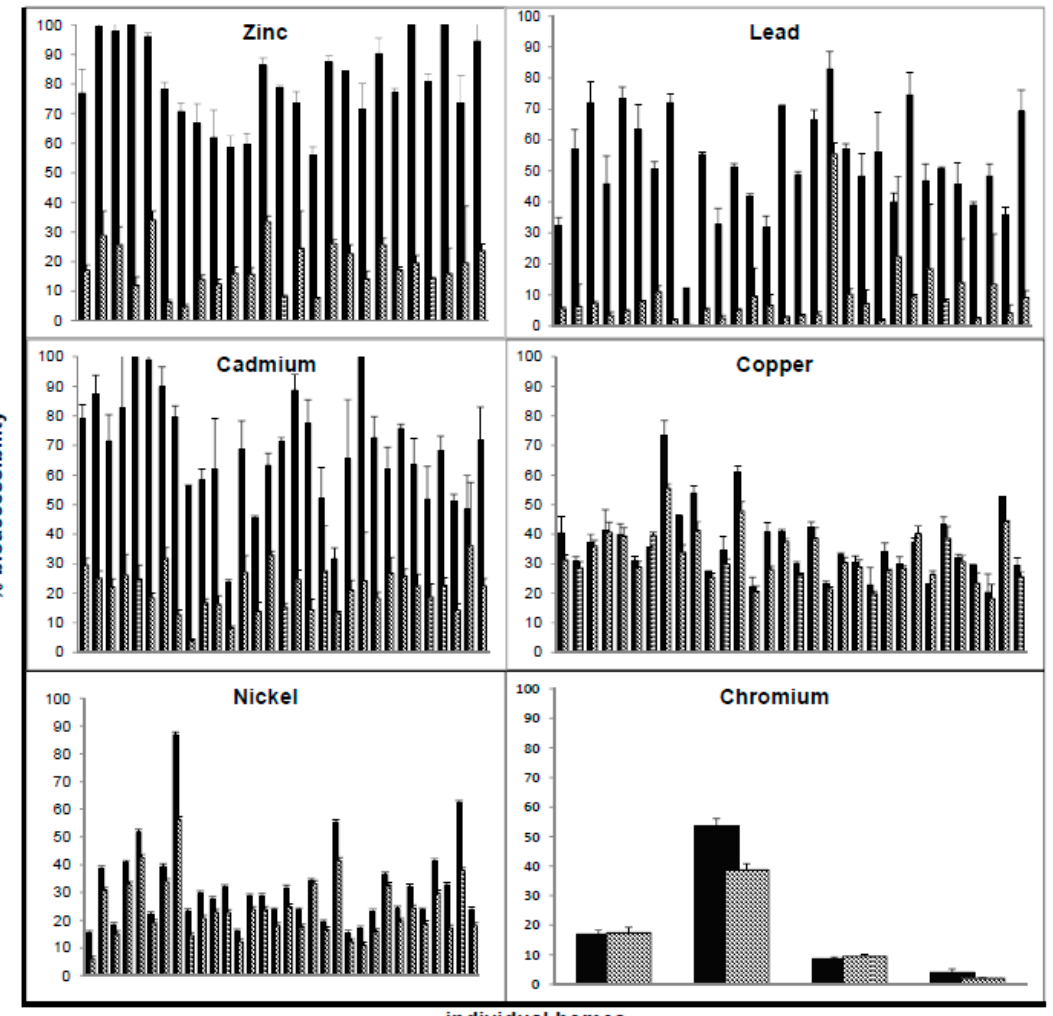
Figure 1. Percent bioaccessibility results for house dust samples comparing gastric (dark bars) and gastrointestinal (light bars) extractions. Bars indicate average of triplicate digests for each home; error bars indicate standard deviation. A total of 33 homes were studied; only results above LOD are shown.